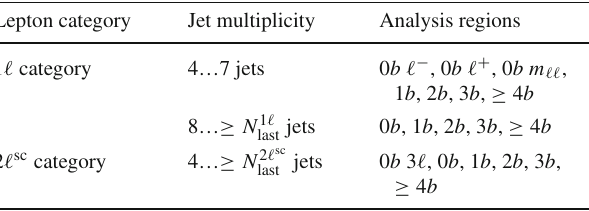
Table 3 Summary of regions considered in the jet counting analysis. The notation N b is used to indicate a requirement on the b -jet multiplic- ity. The highest jet multiplicity considered ( N last ) depends on the jet p T threshold and the lepton category. In the 1 (cid:3) category it corresponds to 15, 12, 11, 10, and 8 jets for the different jet p T thresholds in increas- ing order. In the 2 (cid:3) sc category it corresponds to 10, 8, 7, 7, and 6